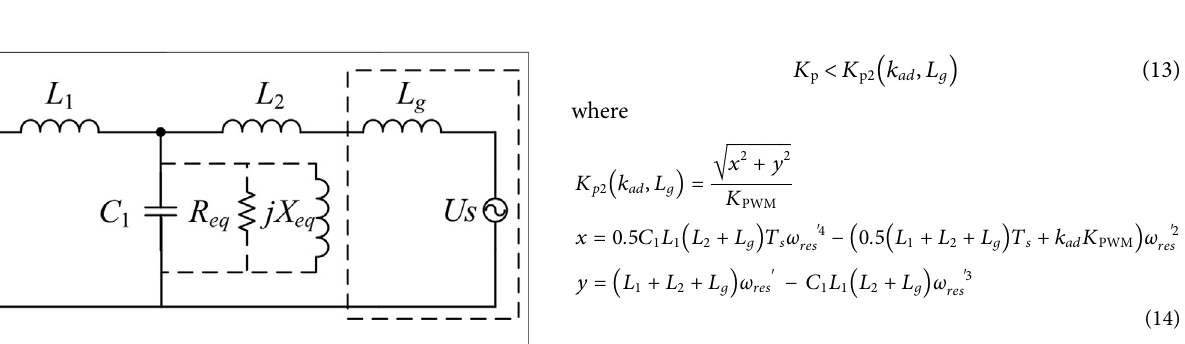
FIGURE 4 | Equivalent closed loop control block diagram of the grid-connected inverter in the αβ coordinate system.